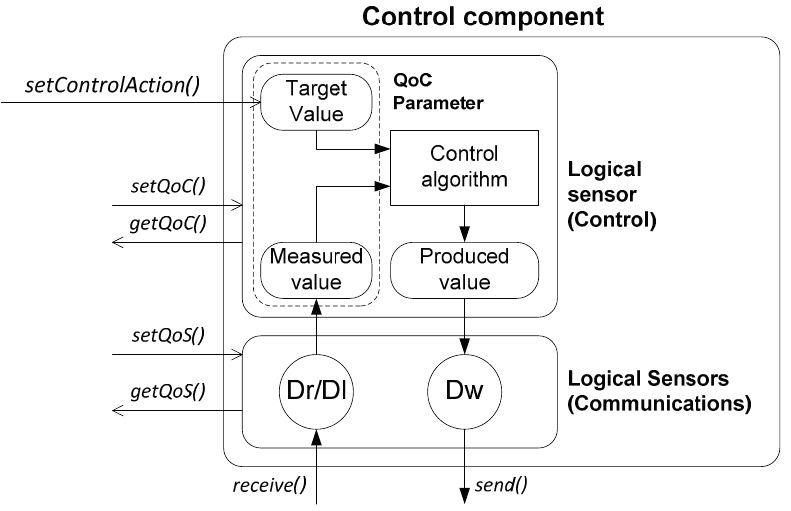
Figure 18. Implementation of the Integral Quality Cycle in a Control Component of the FSACtrl architecture.